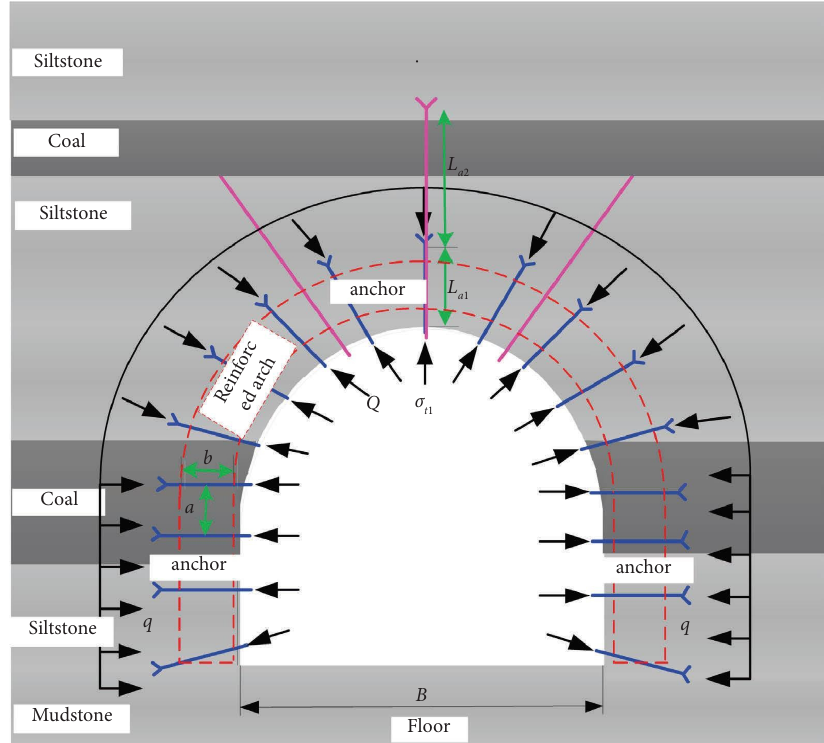
Figure 7: Mechanical model of surrounding rock support